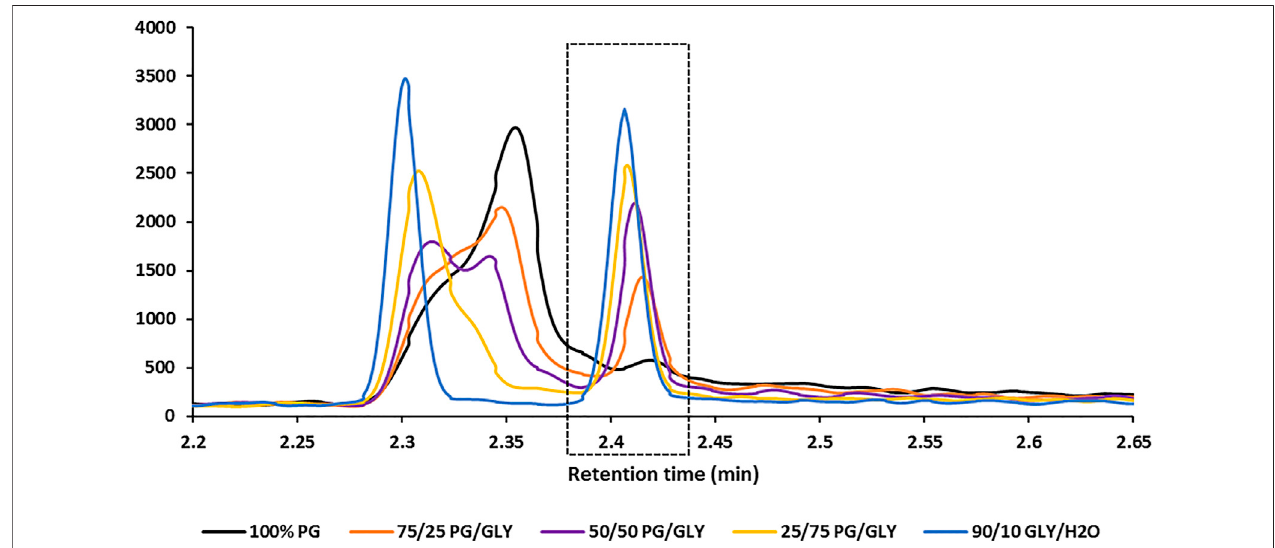
FIGURE 3 | SRM chromatograms of the EG quantitation ion transition in fi ve different blank matrix compositions illustrating the thermal degradation of GLY to produce EG (peak within dashed box). No EG is detected in a 100% PG matrix (no GLY; black trace); however, a corresponding increase in EG is observed with increasing GLY composition.